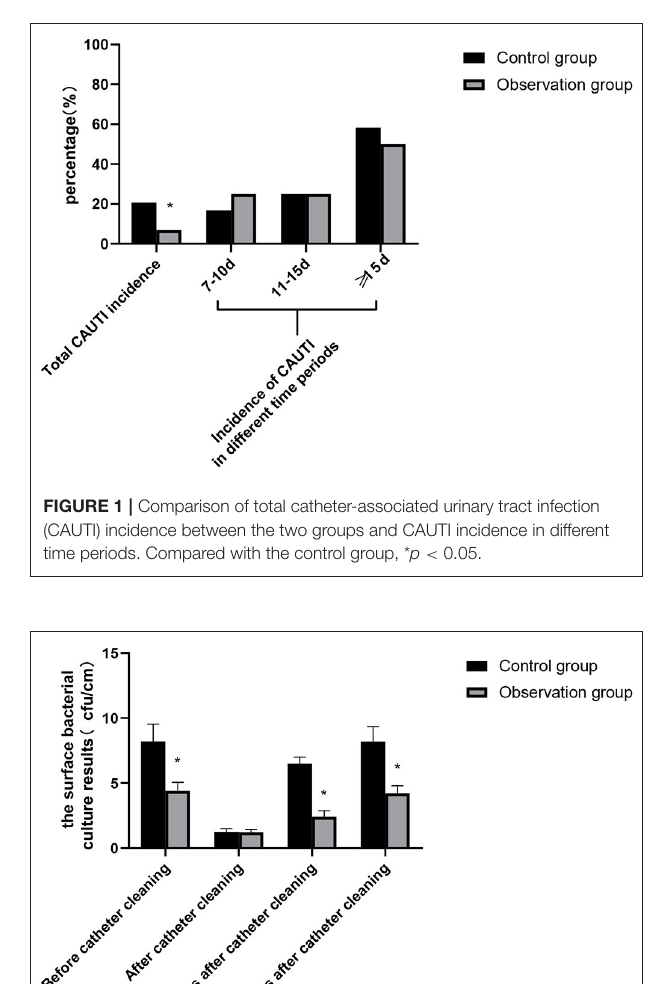
Frontiers in Surgery |